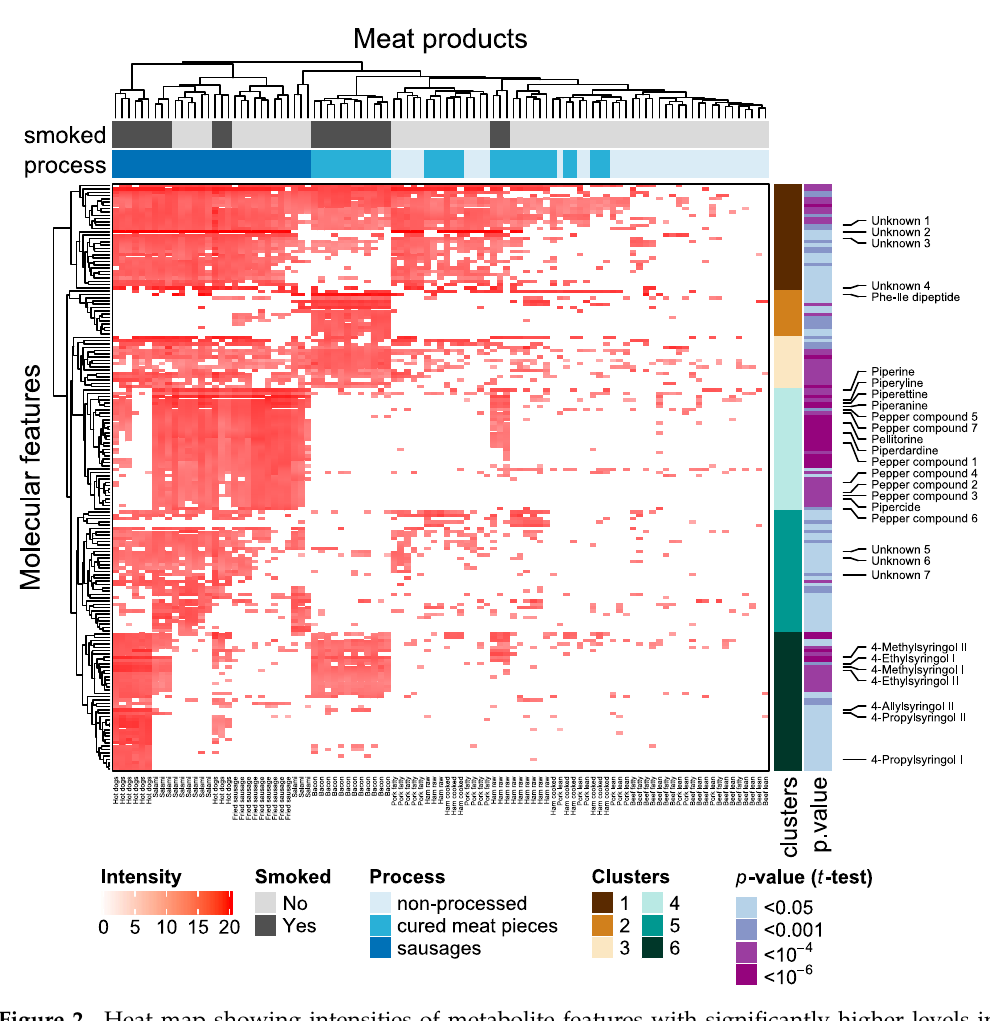
Figure 2. Heat map showing intensities of metabolite features with significantly higher levels in processed meat digests compared to non-processed meat digests. A Welch’s t-test revealed 178 metabolite features with intensities significantly (FDR-adjusted p -value < 0.05) and increased at least twofold in processed meat products ( n = 63) compared to non-processed red meat ( n = 36). Intensities were log transformed. Meat products are displayed in columns and colored by the product type. Metabolite features (rows) are colored by the FDR-adjusted p -value of the t -test. Names of identified metabolites are indicated. Details on these compounds with clusters they belong to are given in Table 2 and Supplementary Materials Table S2.